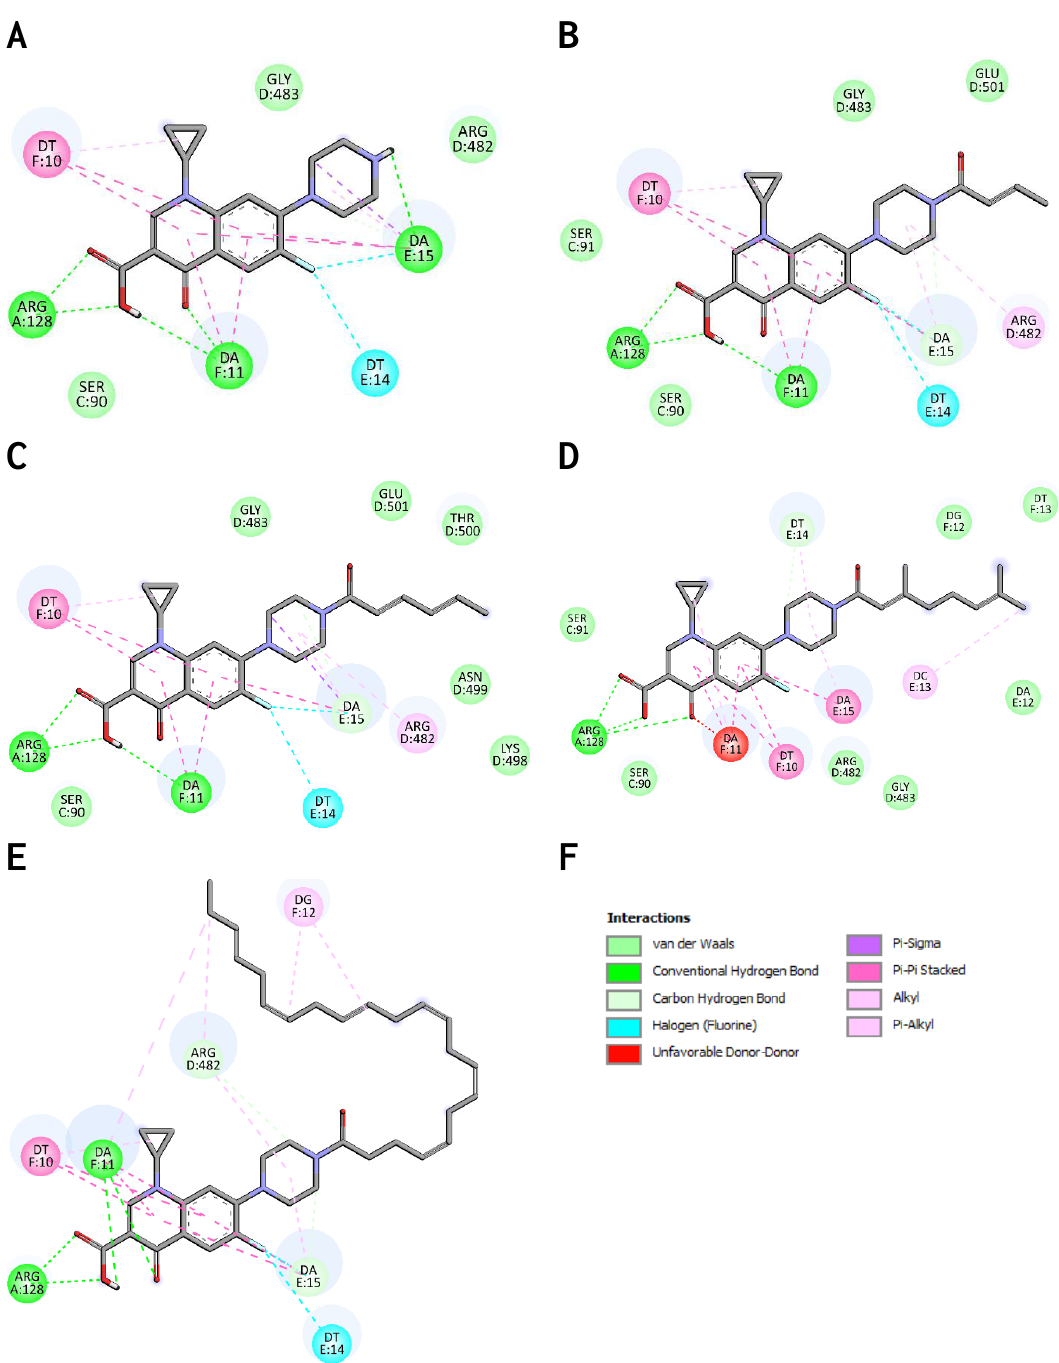
Figure 3. Interactions schemes generated for bound CP, panel ( A ), and its four derivatives: 1 – 3 and 8 panels ( B – E ), respectively. Colors presenting different interaction types are shown in panel ( F ). Figure generated using BIOVIA Discovery Studio.